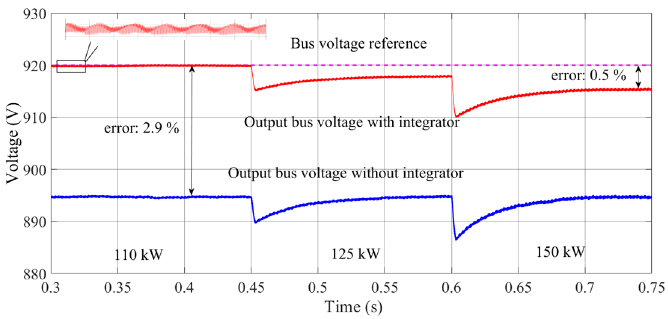
Figure 13. Output voltage V DC during the duty class.